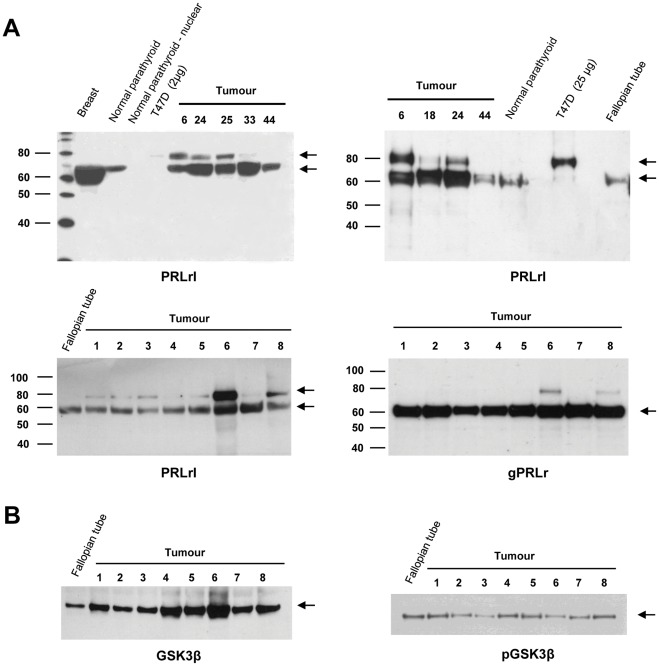
Western blot analysis of protein expression for GSK3β and isoforms of the prolactin receptor.A) Detection of 80 kDa and 60/70 kDa products with the PRLrI antibody in normal tissues, T47D cells and parathyroid tumours, and 60/70 kDa N-glycosylated PRLr products with the gPRLr antibody in parathyroid tumours. B) Expression of total GSK3β (left) as well as Ser9-phosphorylated GSK3β (right) in parathyroid tumours and normal tissue.